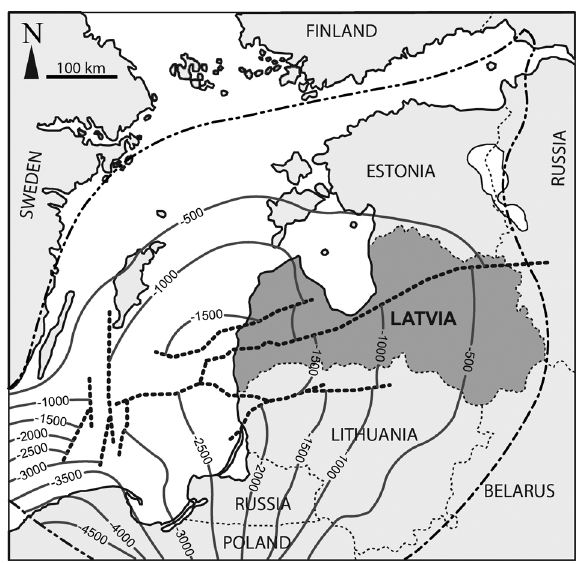
Fig. 2. The southeastern Baltic region and structure map of the Baltic Basin (modified after Šliaupa & Hoth 2011). The contour lines indicate the depth of the top of the Precambrian crystalline basement. The dotted lines show major fault zones. Dark grey marks the research area.